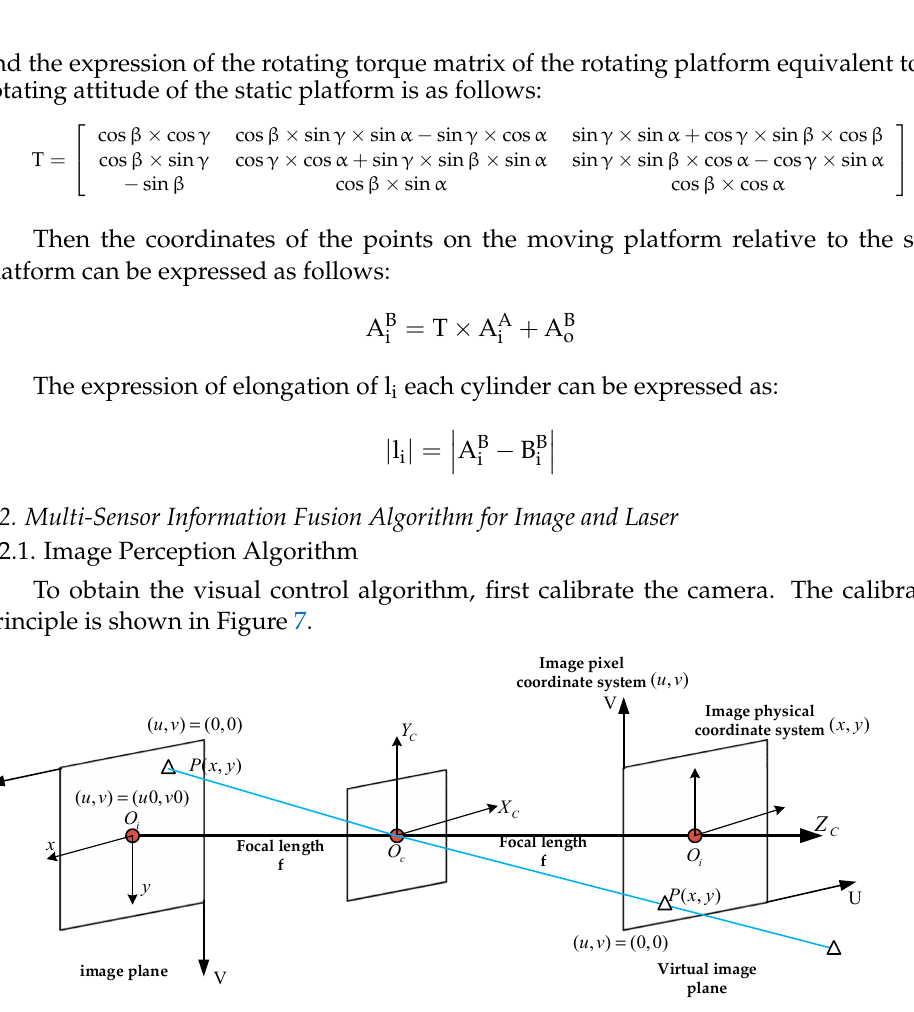
Figure 7. Calibration schematic diagram.